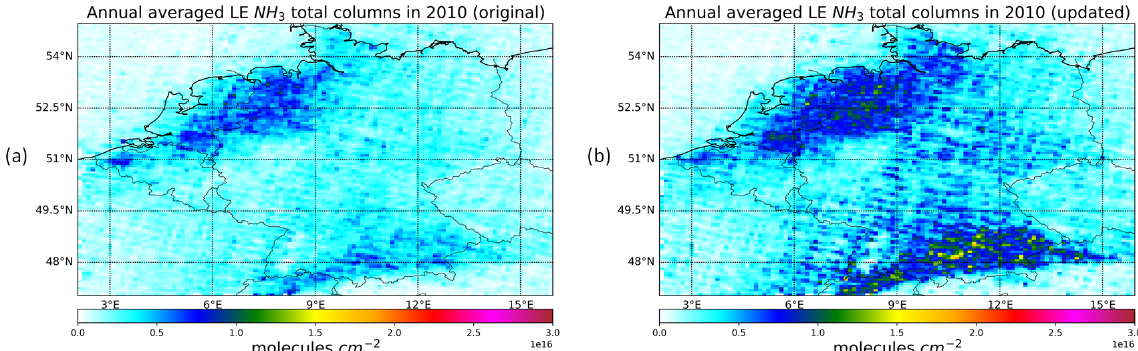
Figure 5. Simulated annual averaged total columns from LOTOS-EUROS using the original MACC-III annual emission distribution and static time profile (a) and using MACC-INTEGRATOR emission totals and updated time profiles (b)